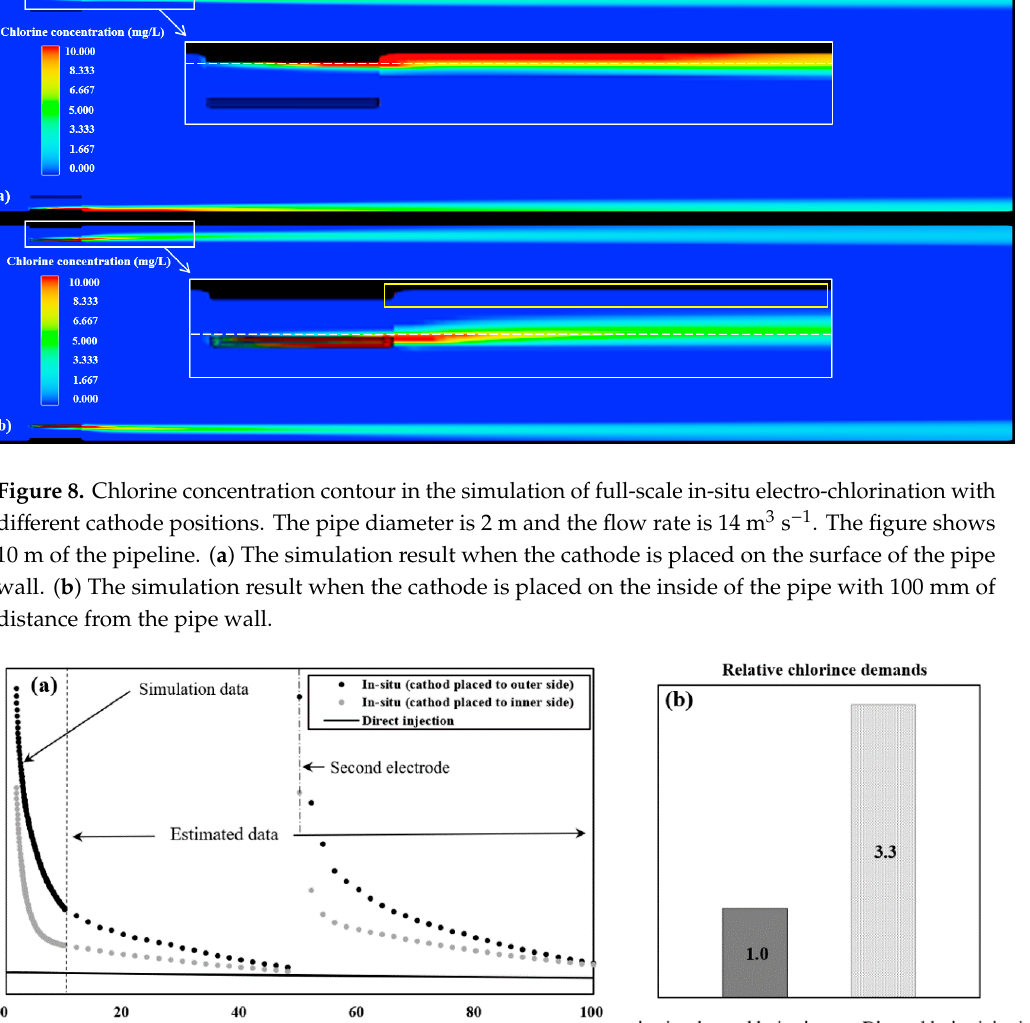
Figure 9. Comparison of in-situ electro-chlorination and direct chlorine injection in full-scale applications. ( a ) Estimated chlorine concentrations along the pipe surface. ( b ) Relative chlorine demands.